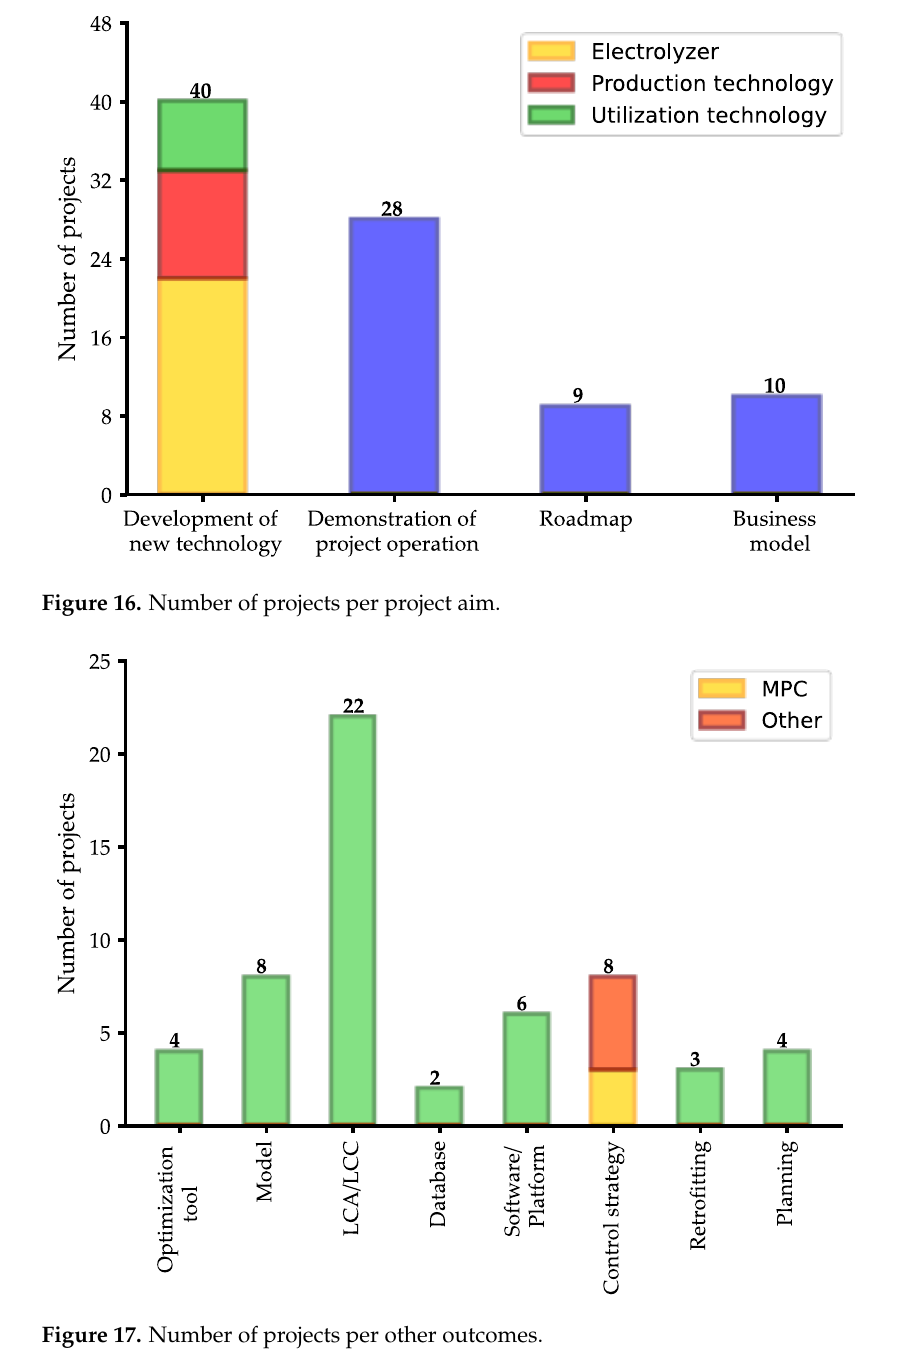
Figure 17. Number of projects per other outcomes.